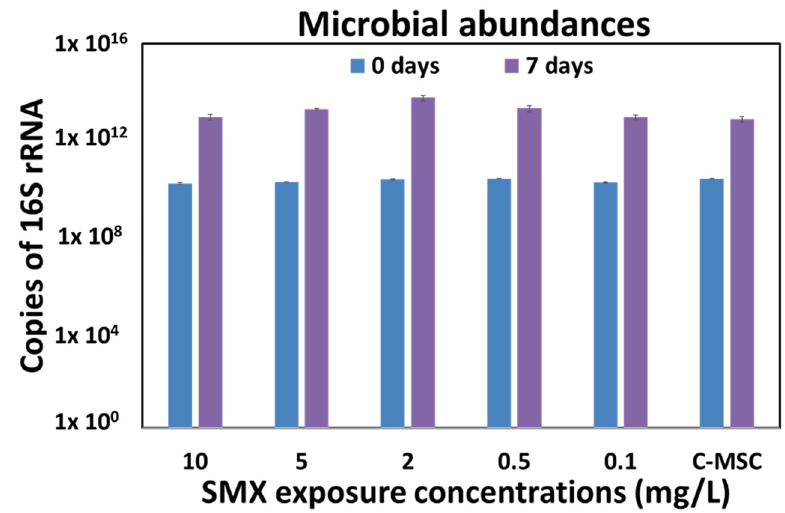
Figure 1. Microbial abundances expressed as 16S rRNA copies under the various SMX concentrations at zero and seven days. C-MSC: free-antibiotic control. The vertical bars represent standard errors. Table 3. Effect of SMX concentrations (10, 5, 2, 0.5, 0.1 mg/L and C-MSC), time (zero or seven days), specific gene ( sul 1, sul 2 or intI 1) on gene